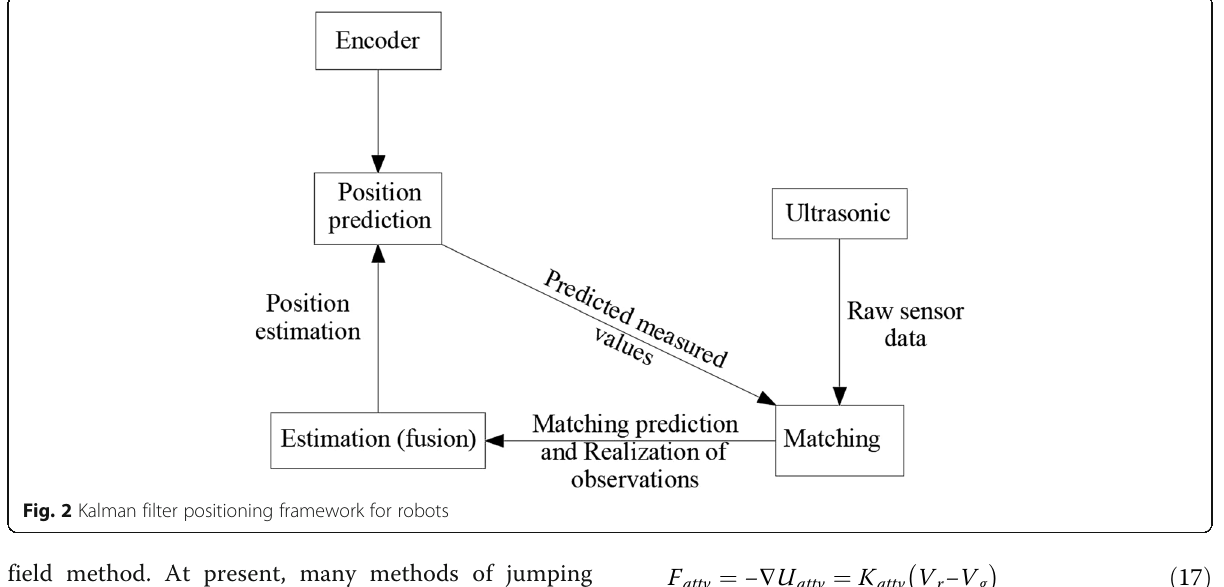
Fig. 2 Kalman filter positioning framework for robots